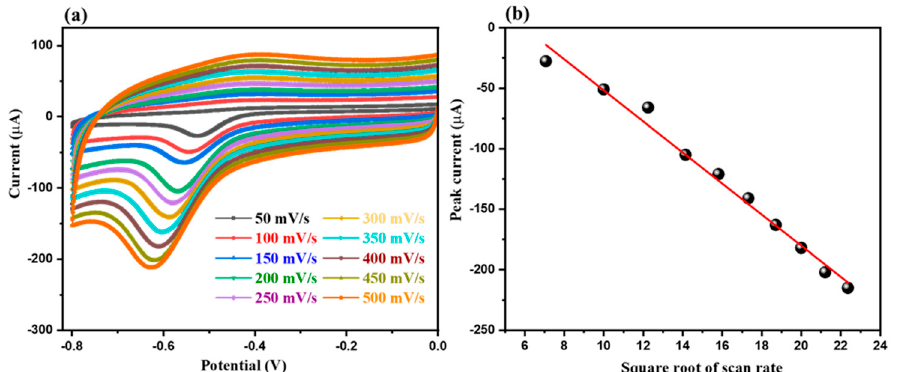
Figure 9. The CV curves ( a ) of N-rGO/SPCE in the presence 0.01 mM H 2 O 2 in 0.1 M PBS of pH 7.0 at different applied scan rates (50–500 mVs − 1 ) and the corresponding linear calibration plot ( b ) between the peak current response versus the square root of the scan rate.